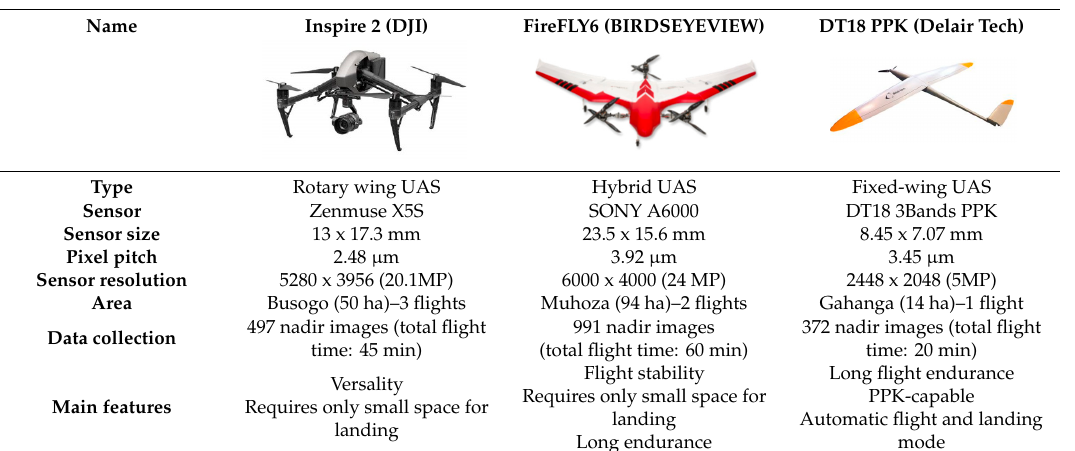
Table 3. Specifications of UAS used in this study.